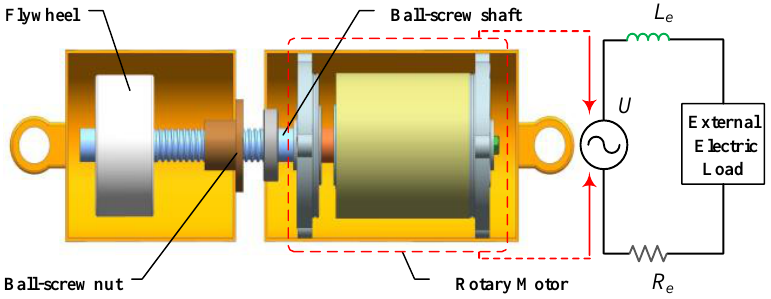
Figure 2. Ball-screw mechatronic inerter.